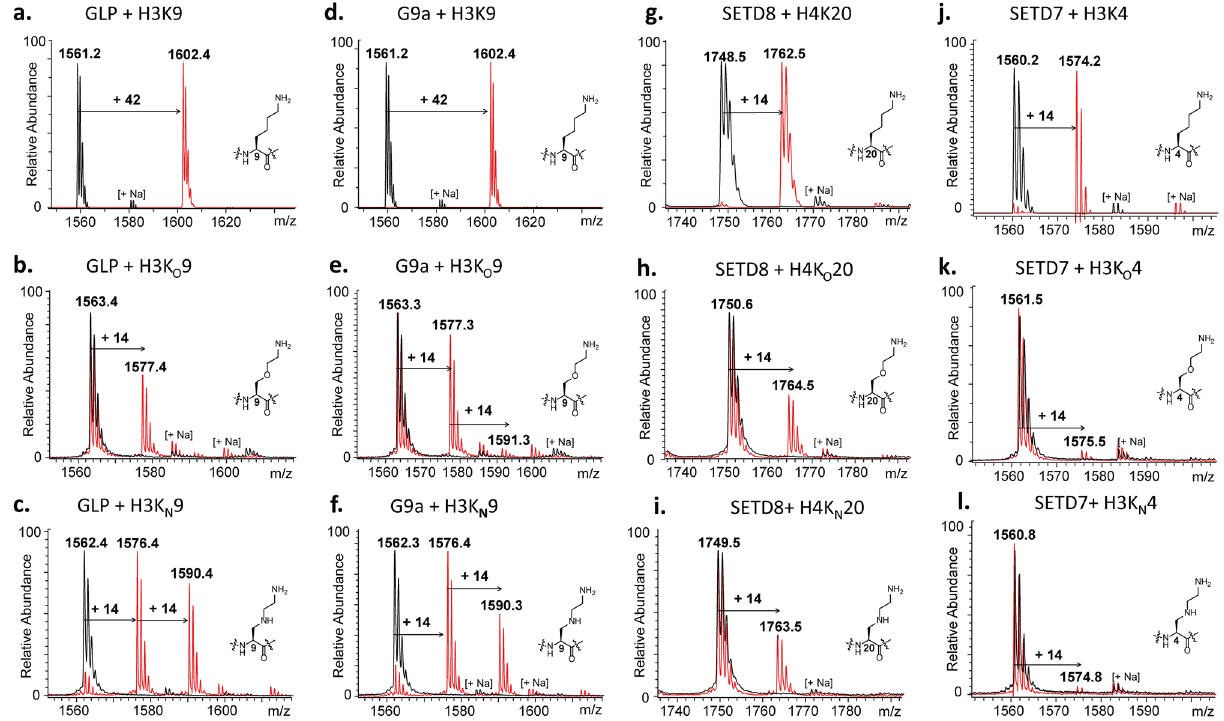
Figure 5. KMT-catalyzed methylation of lysine and its analogues that possess O and NH functionalities at the γ-position. MALDI-TOF MS data showing methylation of histone peptides in the presence of GLP with ( a ) H3K9, ( b ) H3K O 9, ( c ) H3K N 9; and G9a with ( d ) H3K9, ( e ) H3K O 9, ( f ) H3K N 9; and SETD8 with ( g ) H4K20, ( h ) H4K O 20, ( i ) H4K N 20; and SETD7 with ( j ) H3K4, ( k ) H3K O 4, ( l ) H3K N 4. Red spectra show 1 h reactions at 37 °C including KMTs (2 µM), histone peptide (100 µM) and SAM (500 µM for GLP/G9a and 200 µM for SETD8/ SED7) and black spectra the no-enzyme